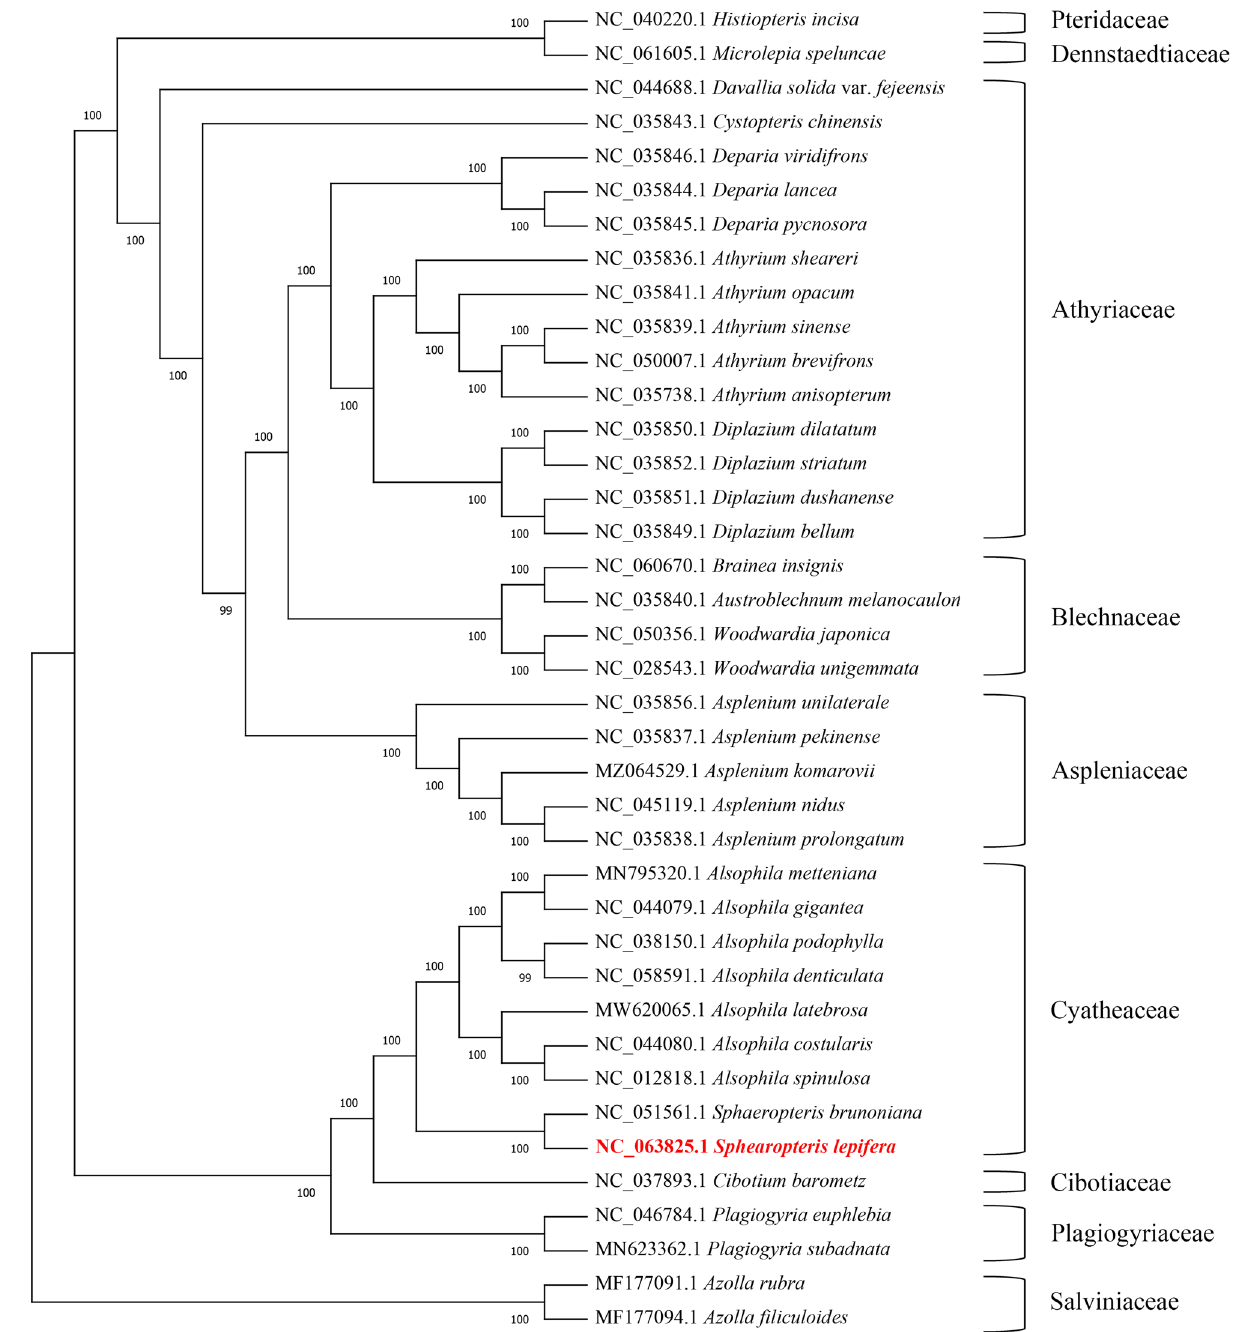
Figure 7. Phylogenetic tree based on the whole chloroplast genome. Phylogenetic tree constructed from 39 species complete chloroplast genome sequences using maximum likeliood (ML) method. Bootstrap values are marked above the